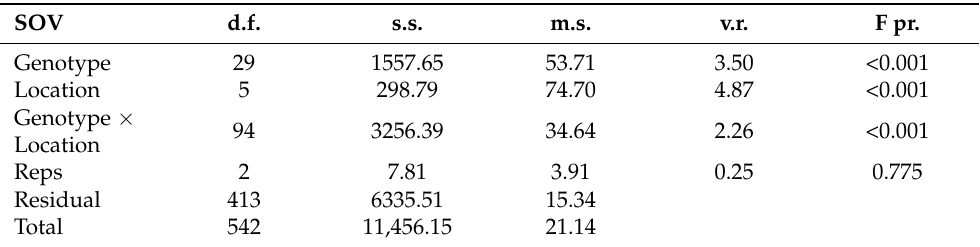
Figure 1. QQ plot showing the correlation between the protein content and normal distribution. Table 3. Analysis of variance of 30 soybean genotypes evaluated for the protein contents (%) in six locations in Uganda.